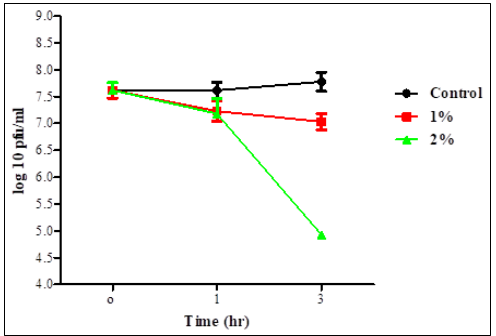
Figure 5. STEC P2 stability in 1 and 2% bile salt. LSD value at